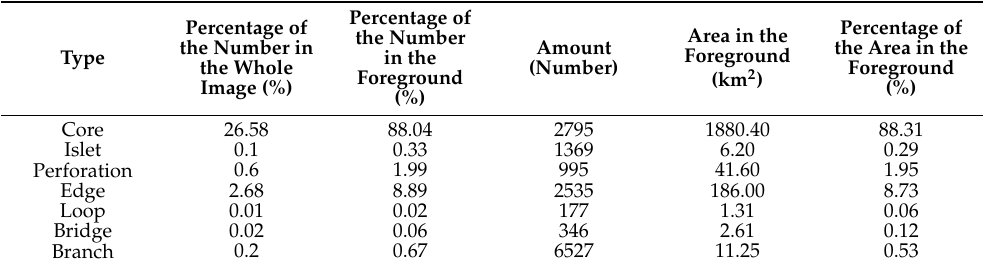
Table 2. Classification result based on